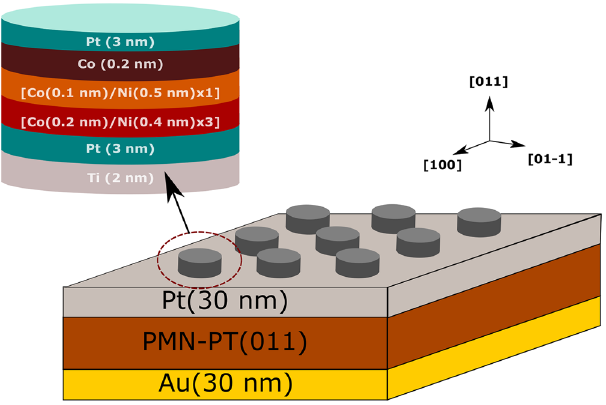
Figure 1. The structure of Co/Ni microdisks on the PMN-30PT